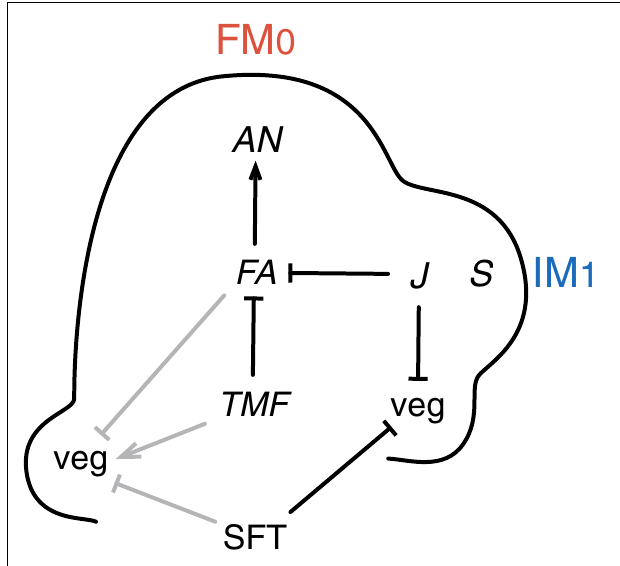
FIGURE 2 | Genetic control of meristem fate in tomato inflorescence. The left side of the diagram shows regulatory interactions (gray lines) at floral transition; the right side shows regulatory interactions (black lines) during the development of the inflorescence. Floral transition of the SAM is controlled by upregulation of FALSIFLORA ( FA ) in the meristem and by systemic SINGLE FLOWER TRUSS (SFT) signal, which both repress vegetative growth (veg). TERMINATING FLOWER ( TMF ) plays an antagonistic role and promotes veg, possibly by repressing FA . During inflorescence development, FA is required for maturation toward flower meristem (FM) fate, together with activation of the FM identity gene ANANTHA (AN) . By contrast, SFT is not required for FM identity but represses veg in the lateral inflorescence meristems (IM). This role is shared with JOINTLESS ( J ) that represses veg and prevents premature maturation of IM toward FM, possibly by repressing FA . By contrast, COMPOUND INFLORESCENCE ( S ) accelerates IM maturation. Repression lines and activation arrows do not mean direct